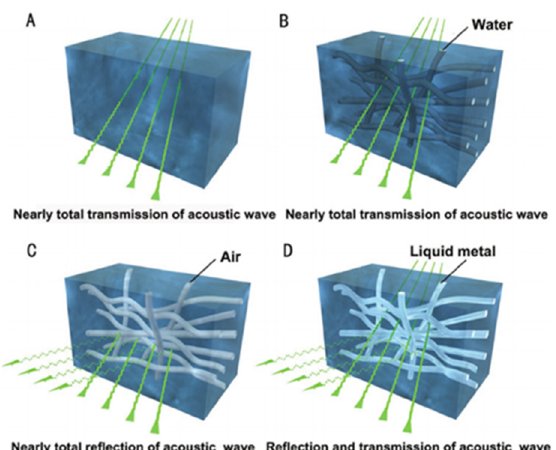
Figure 12. Metagel design consisting of microstructure channels in a tough hydrogel matrix. The acoustic impedance of the hydrogel matches well with water, resulting in almost total transmission of incident waves. These channels can be filled with various liquids to modulate the presenting transmission characteristics of the metagel. In the figure, ( A ) shows “no channels”, with almost total acoustic transmission; ( B ) shows “water-filled channels”, with almost total acoustic transmission; ( C ) shows “air-filled channels”, with almost total acoustic reflection; and ( D ) shows “liquid gallium- filled channels”, with combined transmission and reflection characteristics. (Reprinted from [93], with the permission of John Wiley & Sons Inc.).